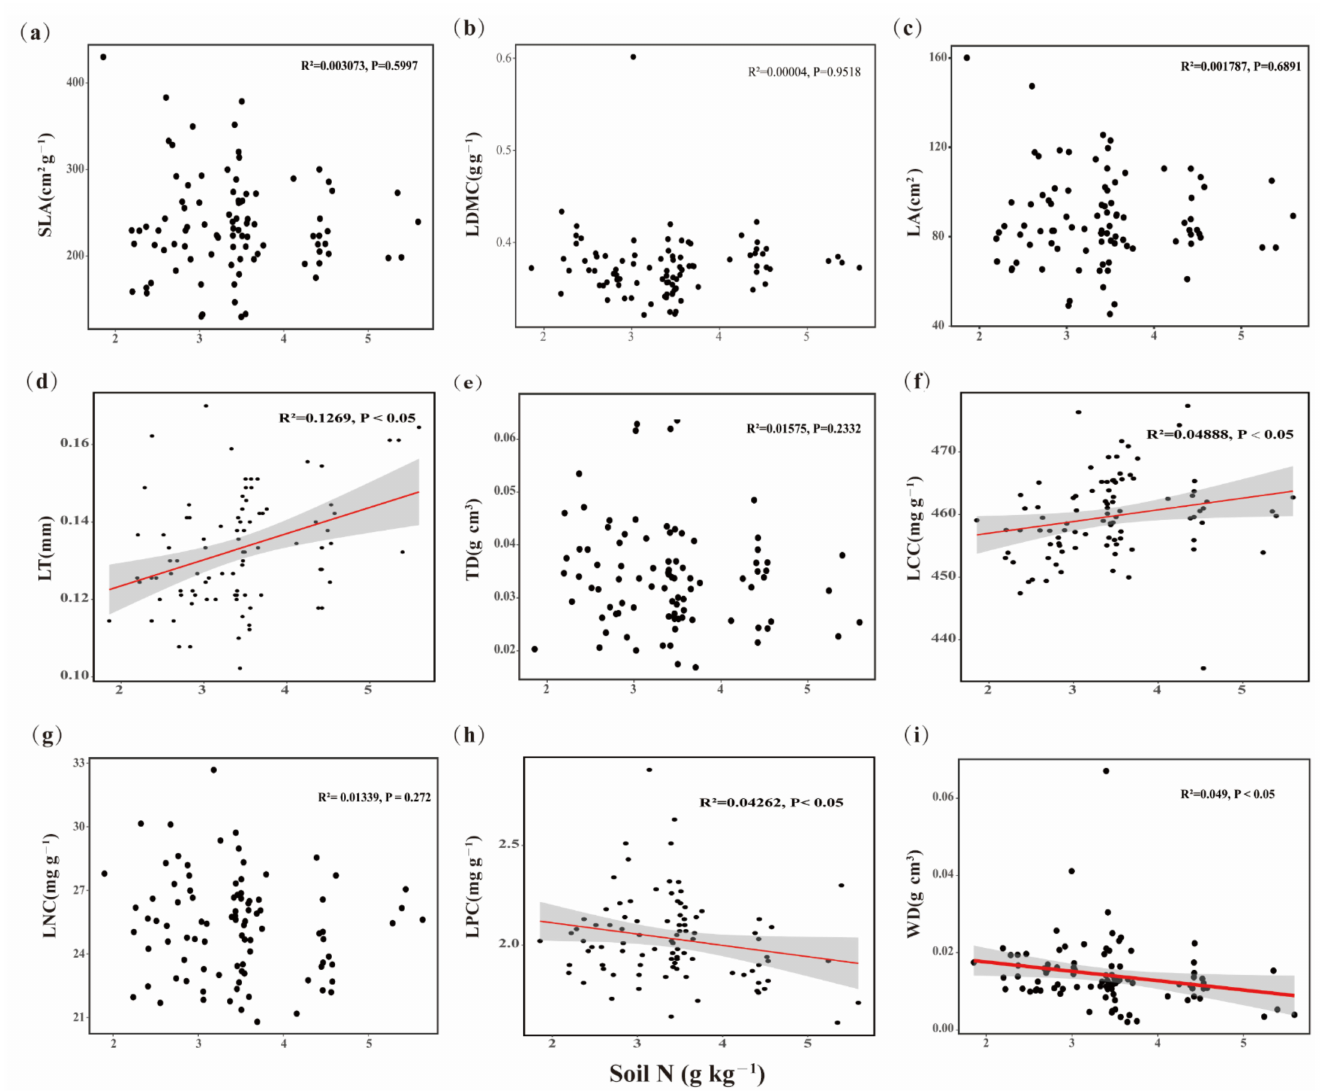
Figure 2. The effects of soil N on functional traits ( a – i ). The shaded regions indicate 95% confidence intervals of the predicted values. Trait abbreviations: SLA (specific leaf area); LDMC (leaf dry matter content); LA (leaf area); LT (leaf thickness); TD (leaf tissue density); LCC (leaf carbon concentration per unit leaf mass); LNC (leaf nitrogen concentration per unit leaf mass); LPC (leaf phosphorus concentration per unit leaf mass); and WD (wood